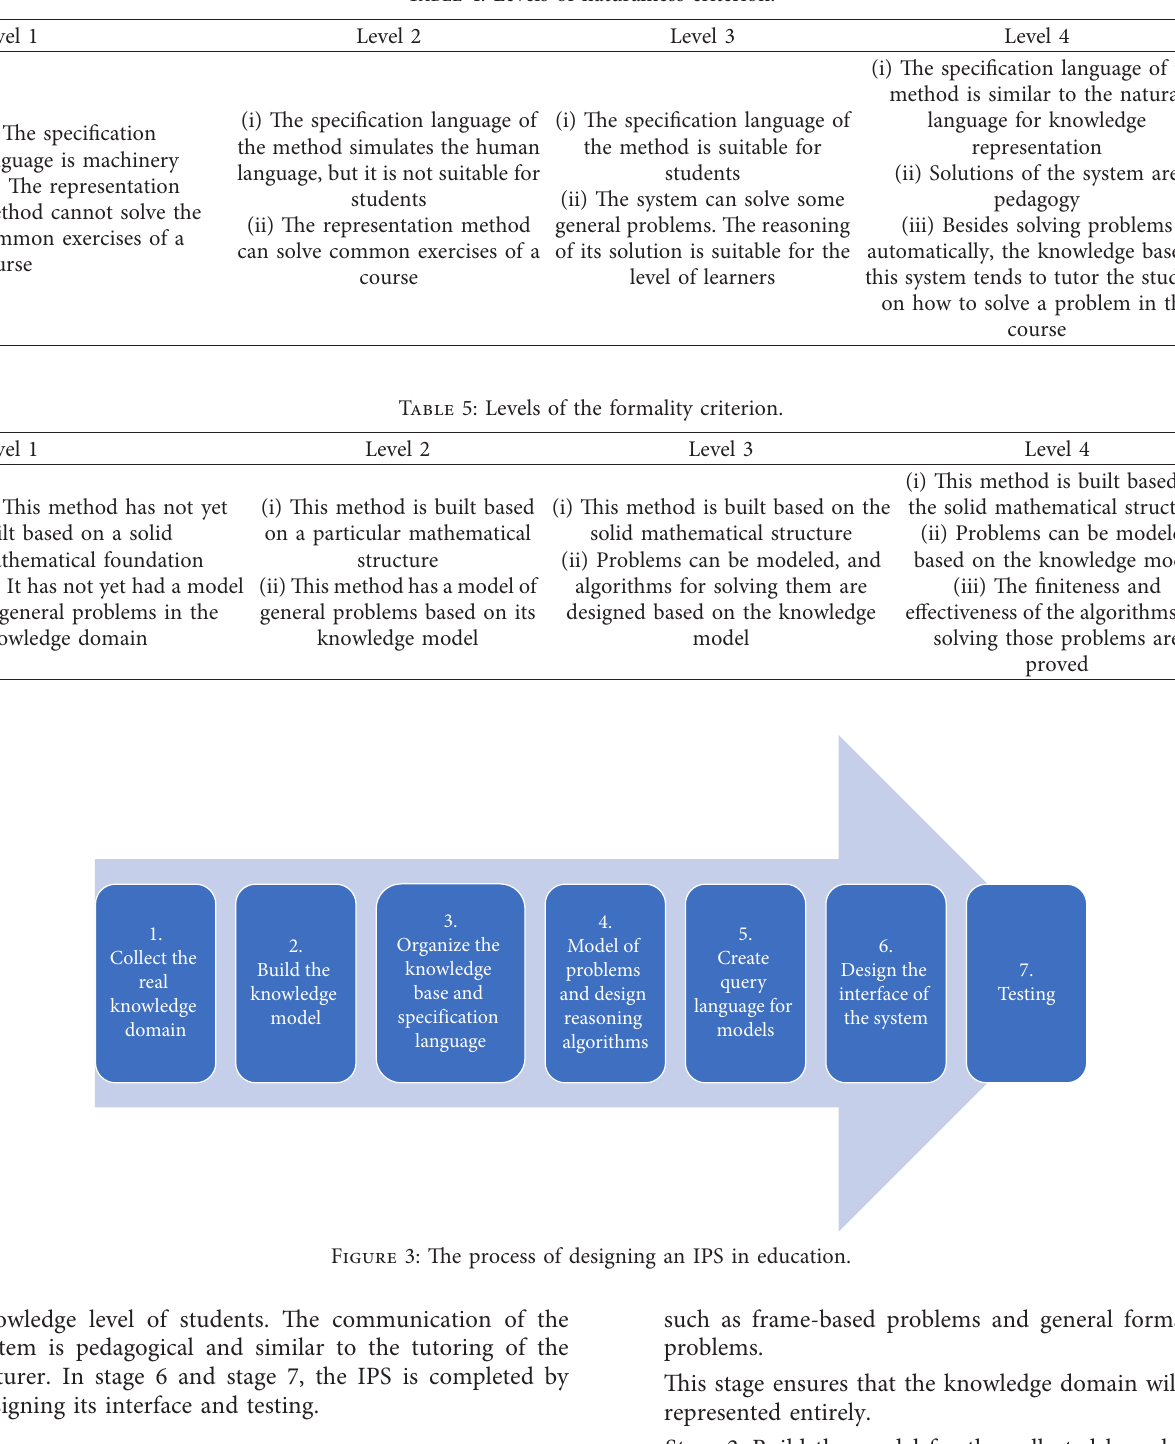
Table 4: Levels of naturalness criterion.